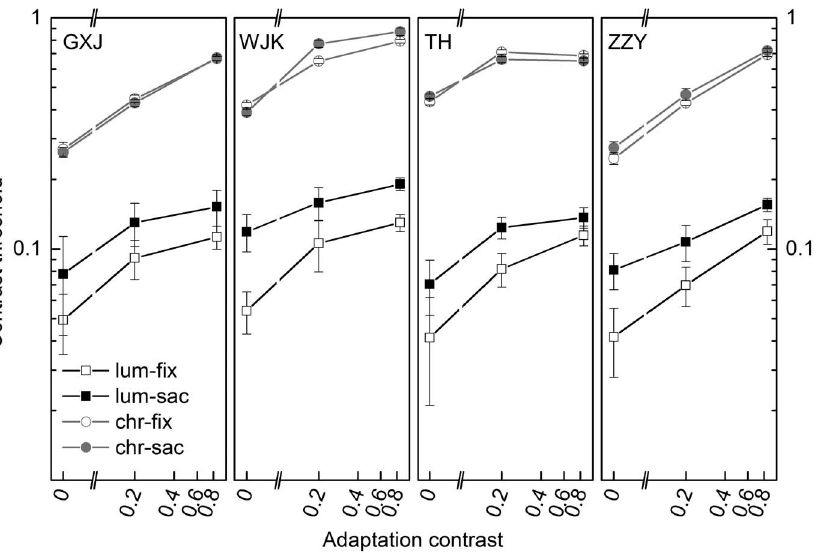
Figure 2. Contrast thresholds when observers were adapted by chromatic and achromatic grating. Fixation and saccade are abbreviated as fix. and sac., and chromatic and achromatic as chr. and achr. Three adaptation contrasts 0, 0.2 and 0.85 were used except for participant TH in his chromatic condition (for simplicity, not illustrated in the data panel). Error bar reports the standard error given by QUEST procedure. Each single line depicts the elevation of contrast threshold after contrast adaptation. For achromatic condition (black line), saccadic suppression is expressed by the distance between fixation (unfilled) and saccade (filled) threshold lines. For chromatic condition (gray line), the two lines almost overlap.